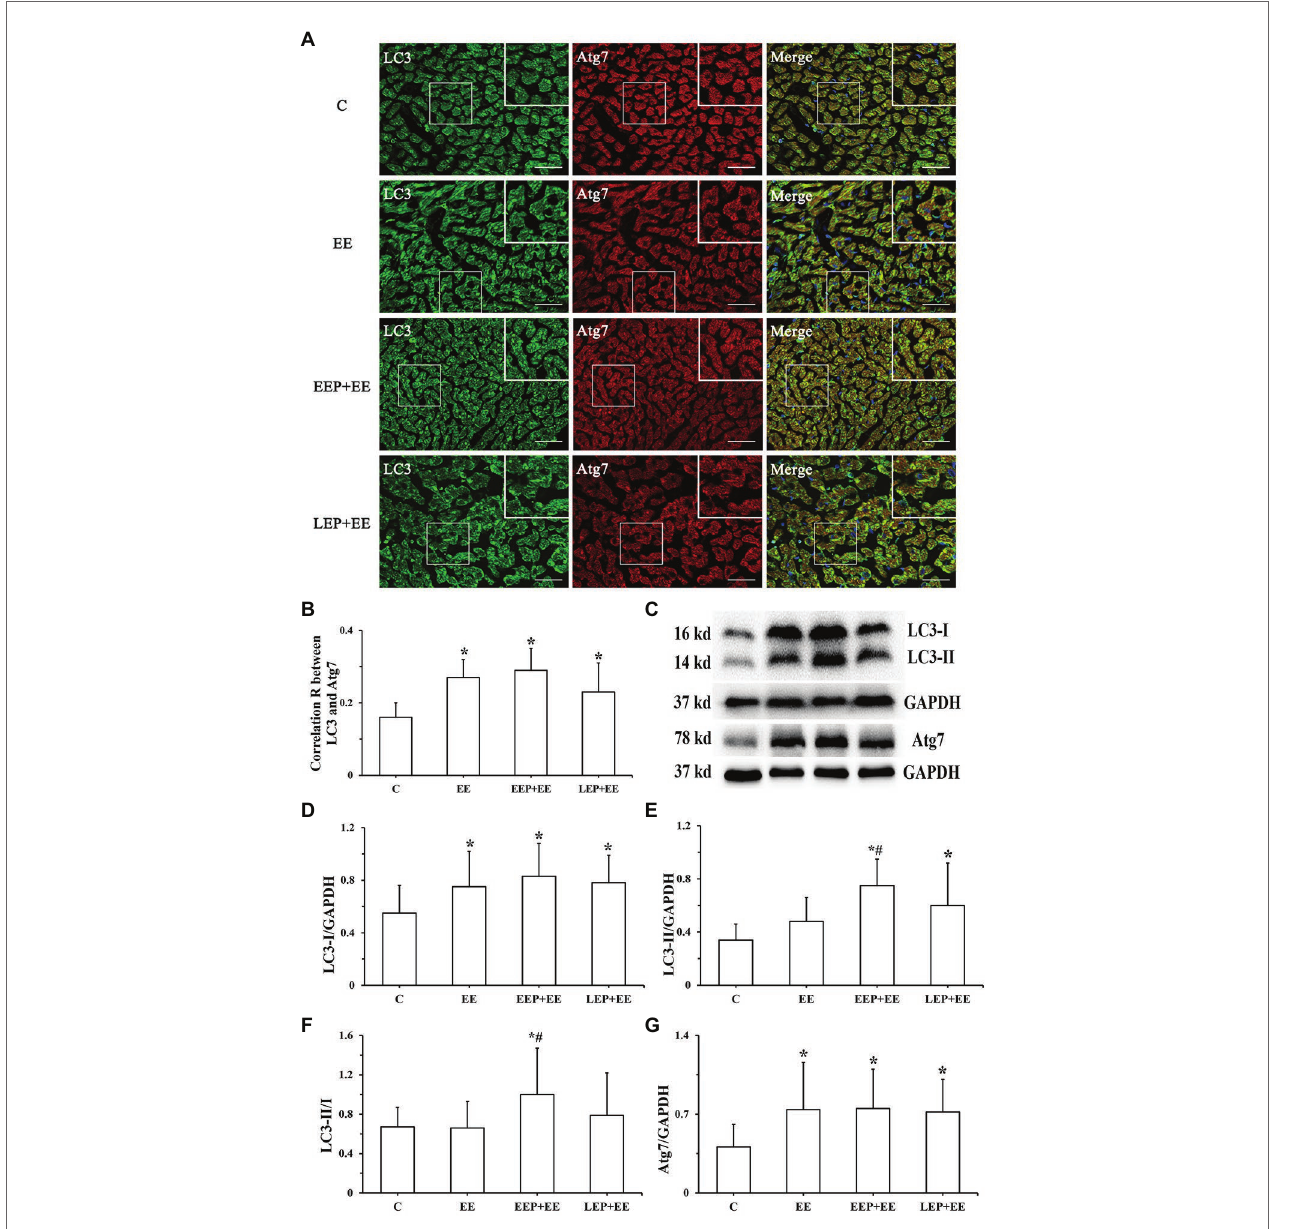
FIGURE 8 | Expression of LC3 and Atg7 levels during EP alleviated myocardial injury induced by exhaustive exercise. (A) Immunofluorescent staining of LC3 and Atg7 in cardiomyocytes (bar = 100 μ m). LC3 immunofluorescence showed green puncta distributed in the cytoplasm. The immunofluorescence images of Atg7 had red puncta distributed in the cytoplasm, and the merged images yielded yellow puncta. (B) Colocalization of LC3 with Atg7 shown as a correlation R. (C) Western blot of LC3 and Atg7. (D) Western blot analysis of LC3-I in different groups. (E) Western blot analysis of LC3-II in different groups. (F) Western blot analysis of LC3- II/LC3-I in different groups. (G) Western blot analysis of Atg7 in different groups. * p < 0.05 vs. group C; # p < 0.05 vs. group